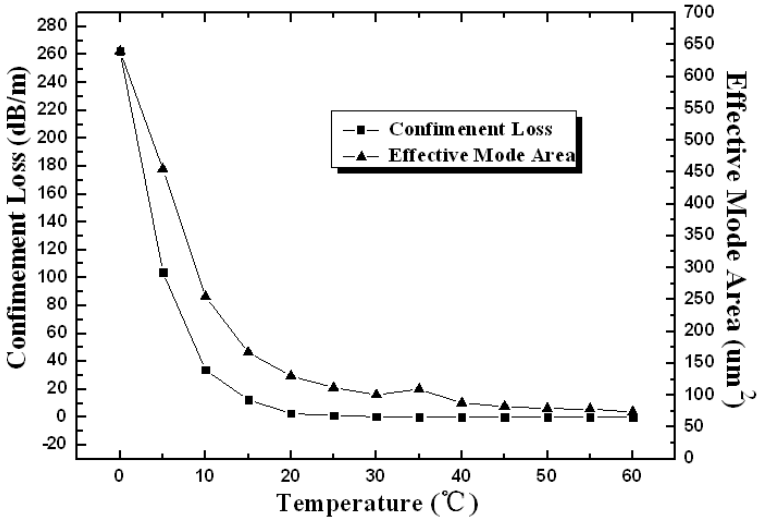
Figure 3. The confinement loss and effective mode area as functions of